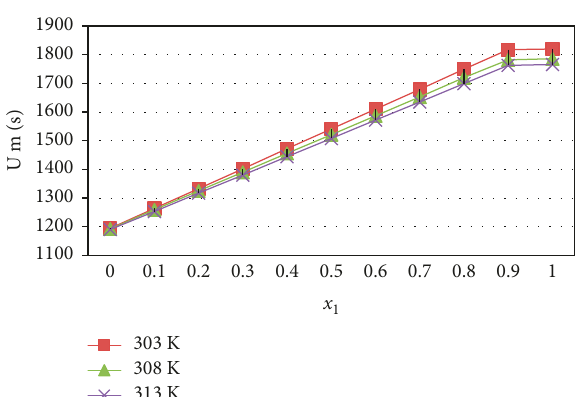
Figure 1: Variation in ultrasonic velocity with mole fraction of chlorpheniramine and 1-propanol at 303K, 308K, and 313K in the atmospheric